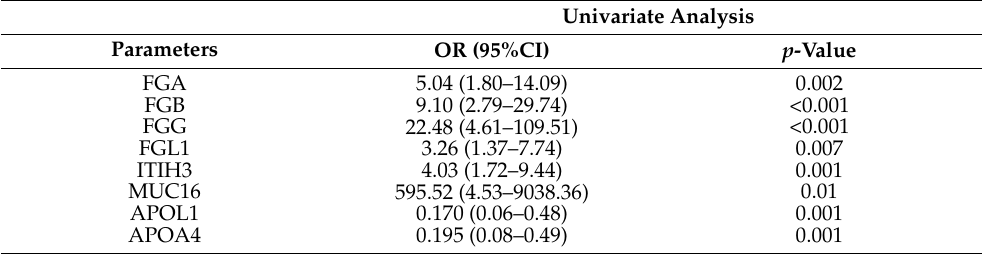
Table 5. The 3-proteins logistic regression model for ovarian cancer diagnosis. Proteins Functions